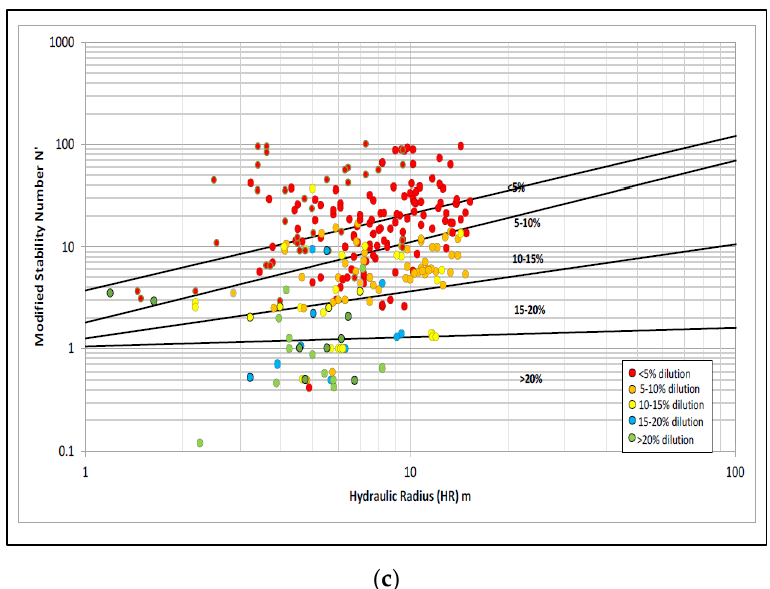
Figure 2. ( a ) Modified stability graph by Potvin [10]. ( b ) Extended Mathews’ stability graph by Mawdesley et al. [11]. ( c ) Dilution-based stability graph by Papaioannou and Suorineni [12].